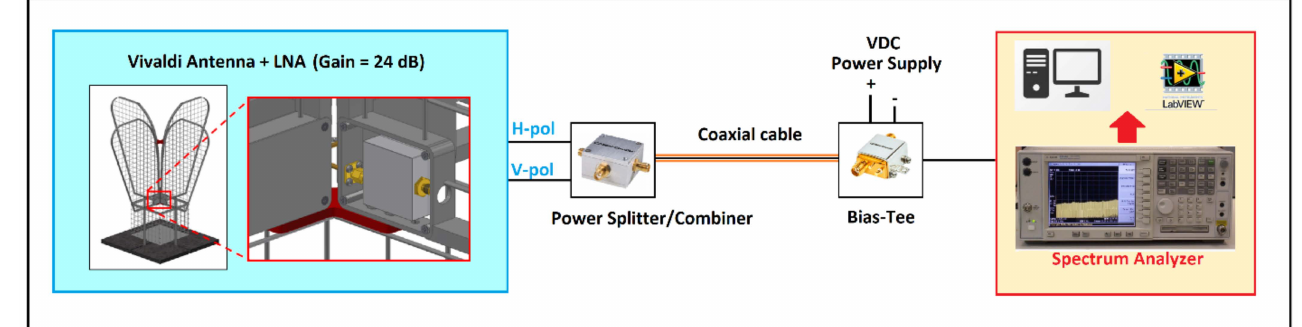
Figure 6. Schematic of the RFI monitoring system based on one of the Vivaldi antennas of the Sardinia Aperture Array Demonstrator (SAD) [45,46].